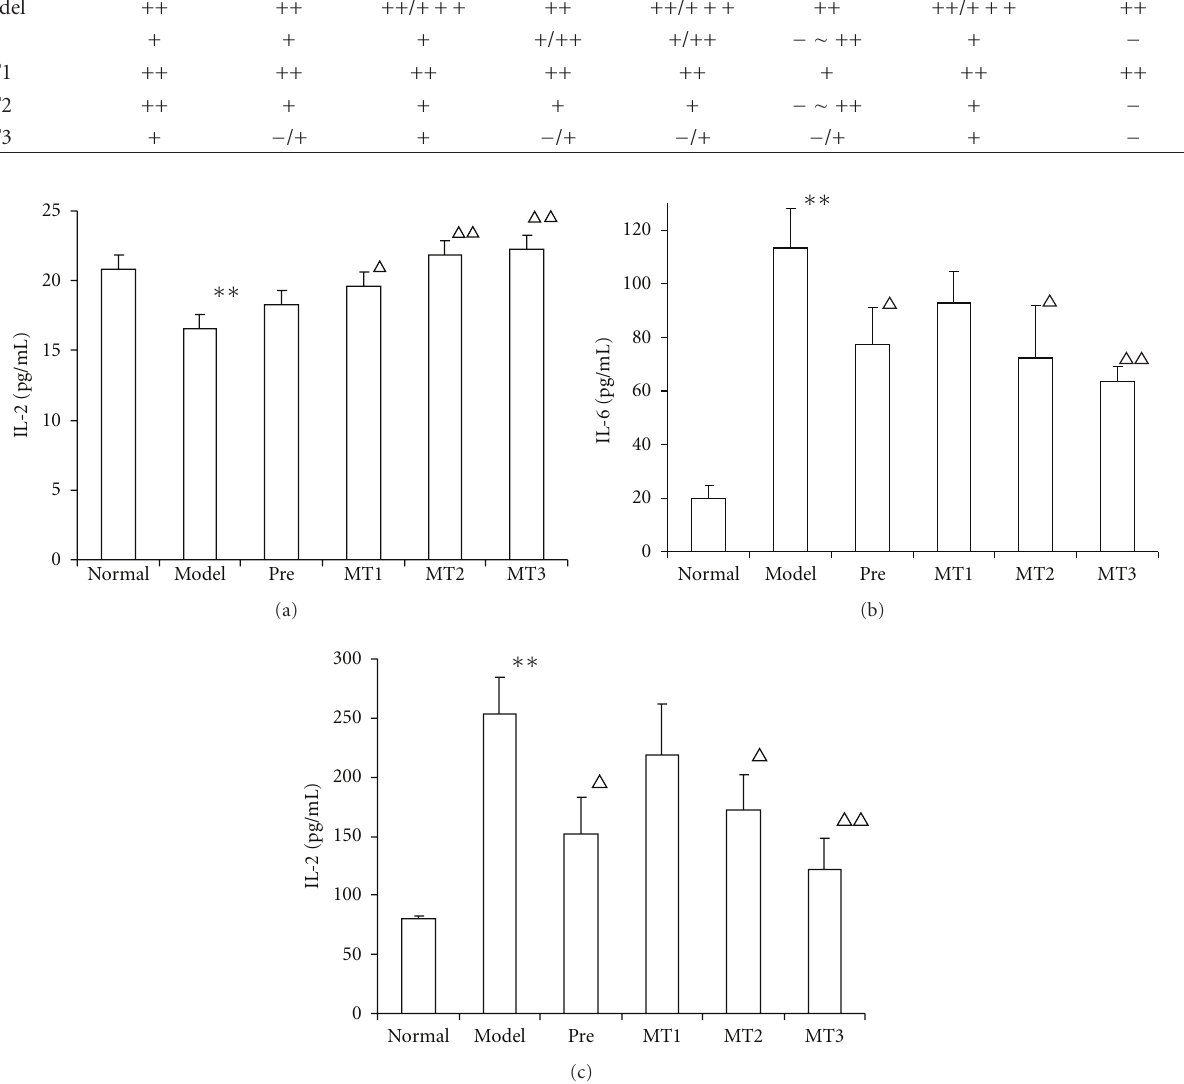
Figure 2: All mice were sacrificed at the end of 24 weeks, and splenic lymphocytes were seeded at 1 × 10 6 cells/well. IL-2 concentrations in splenic lymphocytes were stimulated for 48 h with 3mg/L ConA. IL-6, and IL-13 concentrations in splenic lymphocytes were stimulated for 48h with 12mg/L LPS. IL-2, IL-6, and IL-13 concentrations in culture supernatants were detected by ELISA. Data were given in mean ± SD ( n = 4–5). ∗∗ P < . 01, ∗ P < . 05 versus Normal control group, (cid:2) P < . 05, (cid:2)(cid:2) P < . 01 versus Model control